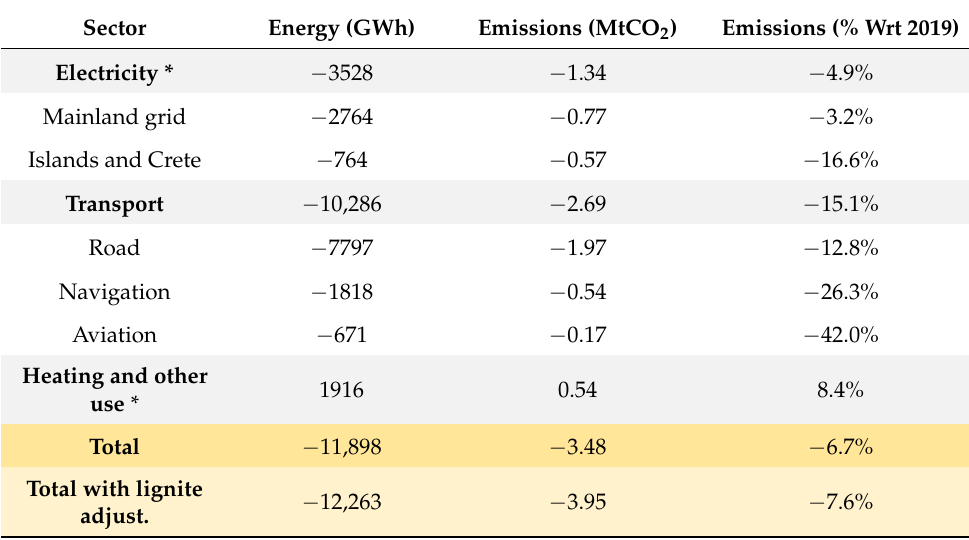
Table 9. Changes 2020–2019 due to COVID